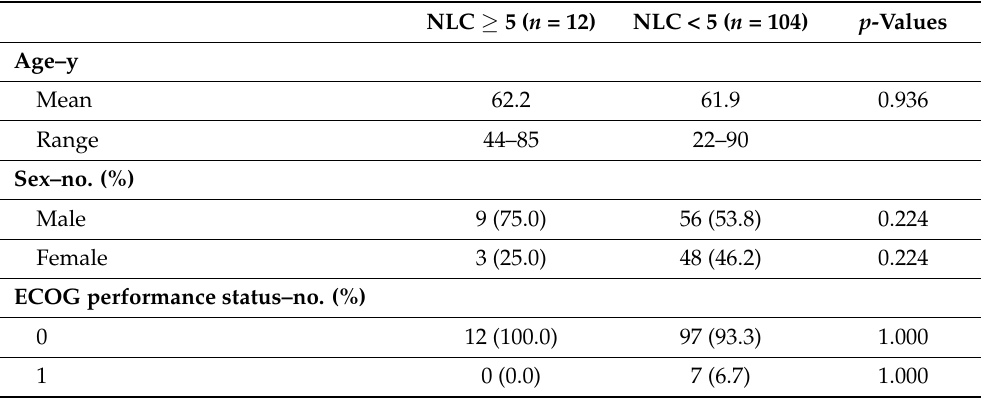
Table A1. Baseline characteristics of the patients stratified by neutrophil-to-lymphocyte ratio (NLC). Percentages are given in